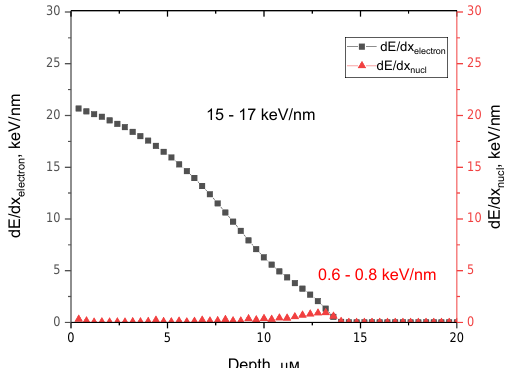
Figure 1. Simulation results of ionization losses of incident ions in the target material.